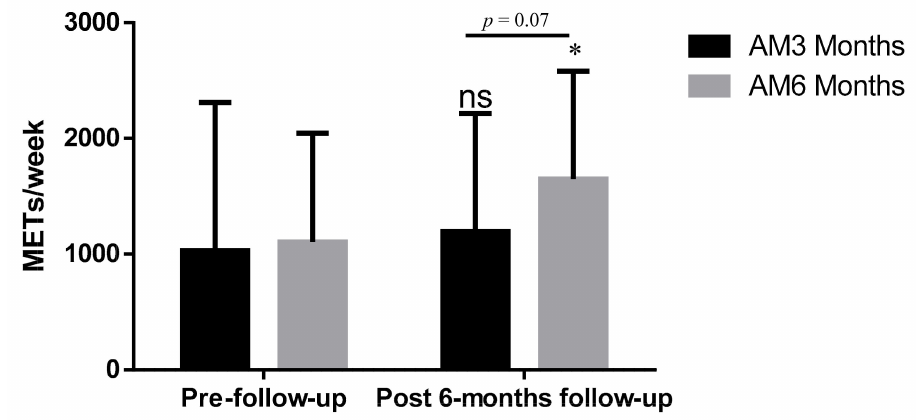
Figure 3. METs / min per week performed in AM3 and AM6 at the beginning and 6 months after the exercise program. ns: no significant e ff ects between pre- and post-6 months follow up; * p < 0.05 significant di ff erences between baseline and 6 months follow up.